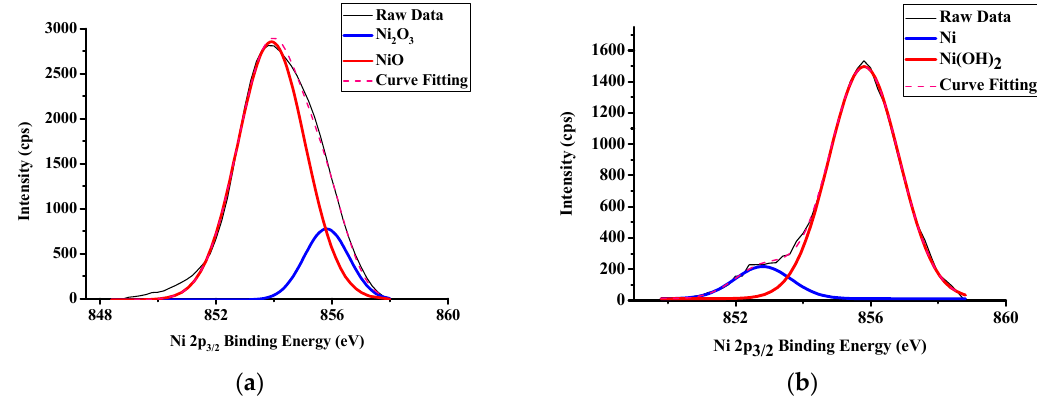
Figure 15. XPS results of Ni ( a ) Before Ar + O 2 plasma treatment ( b ) After Ar + O 2 plasma treatment.